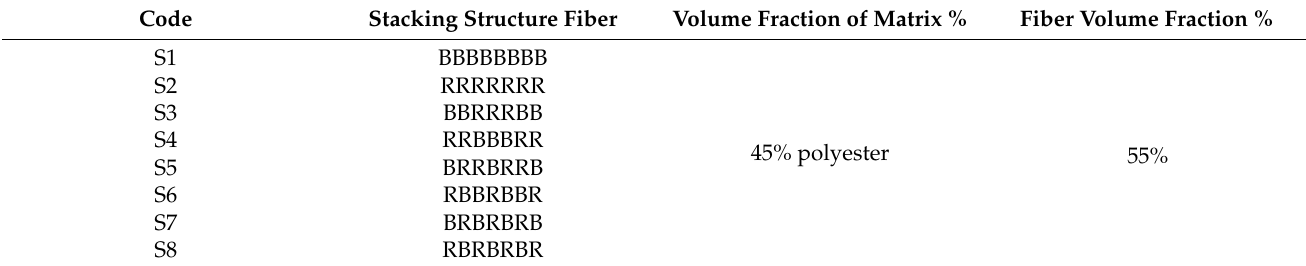
Table 2. Compositions of specimens neatly arranged.